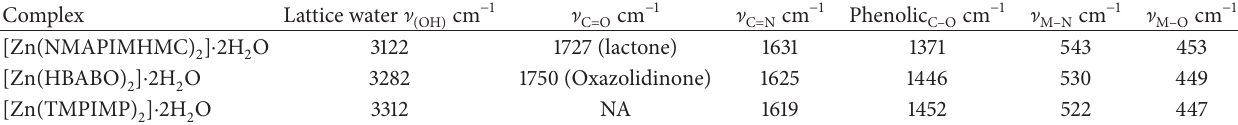
Table 2: FT-IR bands for metal complexes and their assignments.